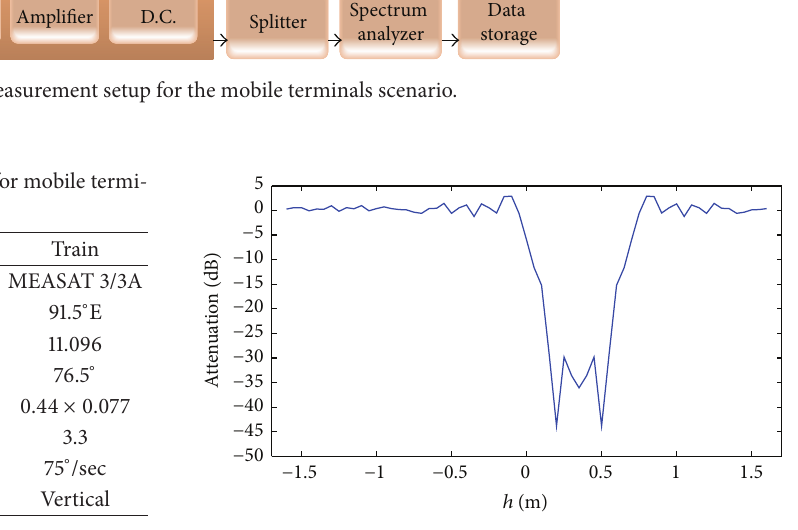
Figure 9: Attenuation owing to power arch supply (PAs) diffraction at Ku-band; the antenna diameter effect, line of sight (LOS) Malaysia parameters.